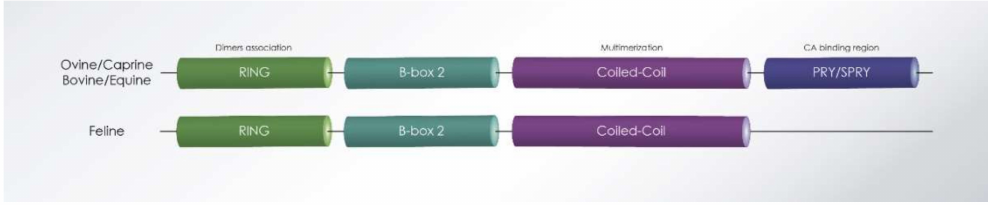
Figure 5. Schematic representation of ovine, caprine, bovine, equine, and feline Tripartite motif-containing protein 5 alpha (TRIM5 α ). RING, B-box-2, coiled-coil, and PRY/SPRY domains are represented. Feline TRIM5 α lacks the PRY/SPRY domain because of a premature stop codon in the mRNA transcript. Predicted structure of GenBank accession numbers: JN835300-JN835311 (ovine)